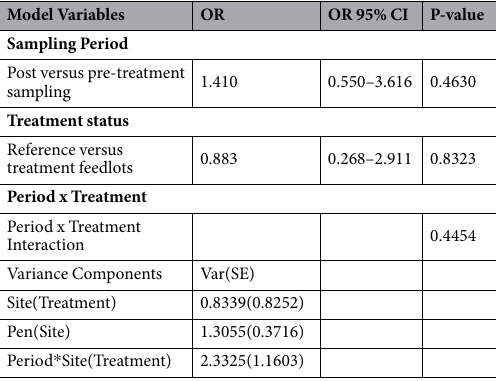
Table 2. Odds ratios from multivariable mixed-effects logistic regression model used to test the efficacy of targeted control of invasive bird species as a pre-harvest intervention strategy to control ciprofloxacin-resistant Escherichia coli cattle fecal